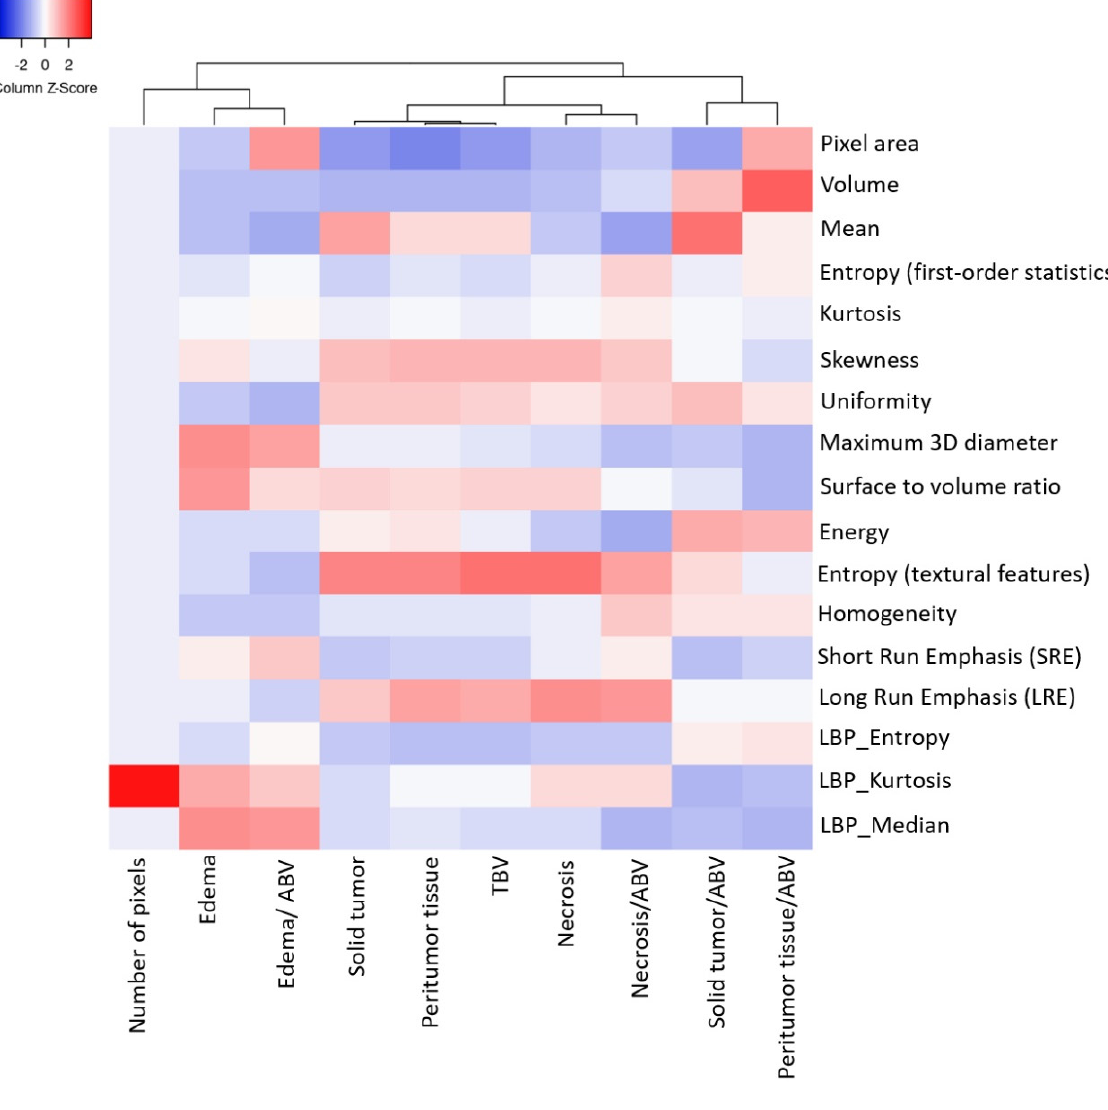
Figure 5. The heatmap manifests the absolute quantification radiomics feature values with high to low feature values in red to blue. The data showing hierarchical cluster analyzed using MR radiomics features and cluster distance implied the order in which clusters were associated.